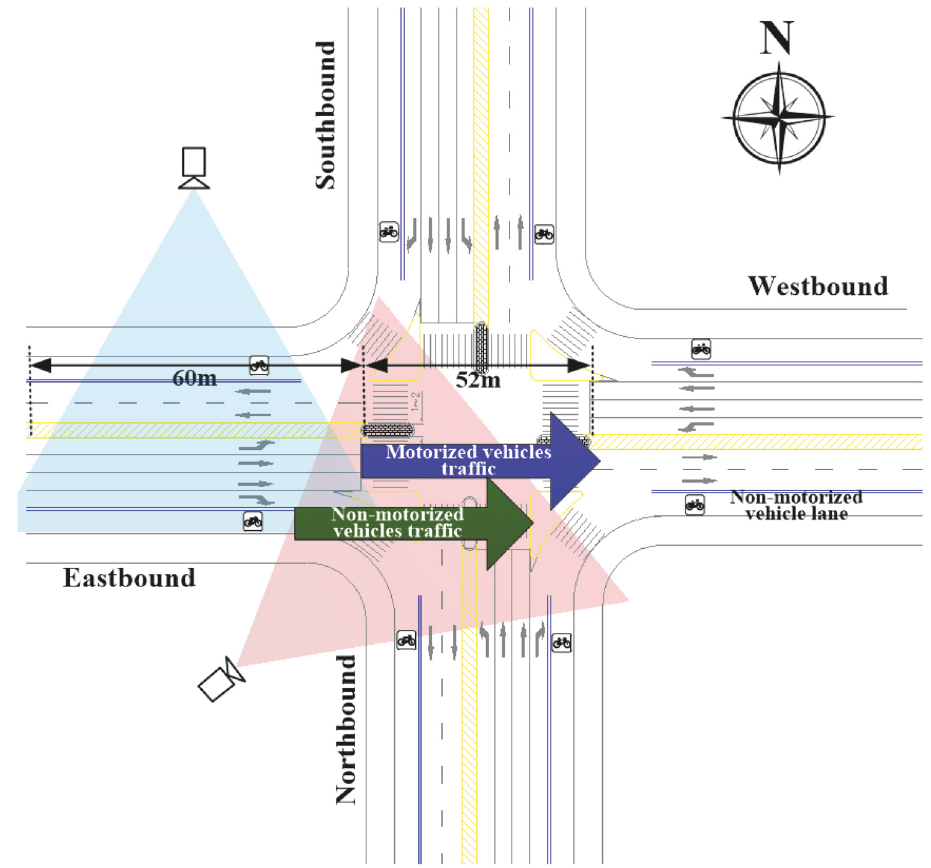
Figure 1: Diagram of trajectory collection at intersections. Blue camera was mounted 20 m above the road and red camera at road height.